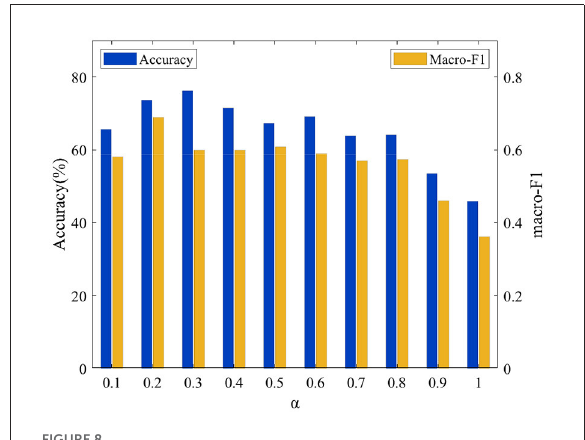
FIGURE8 Acc and macro F1 for different α on the PHAC-2 dataset.